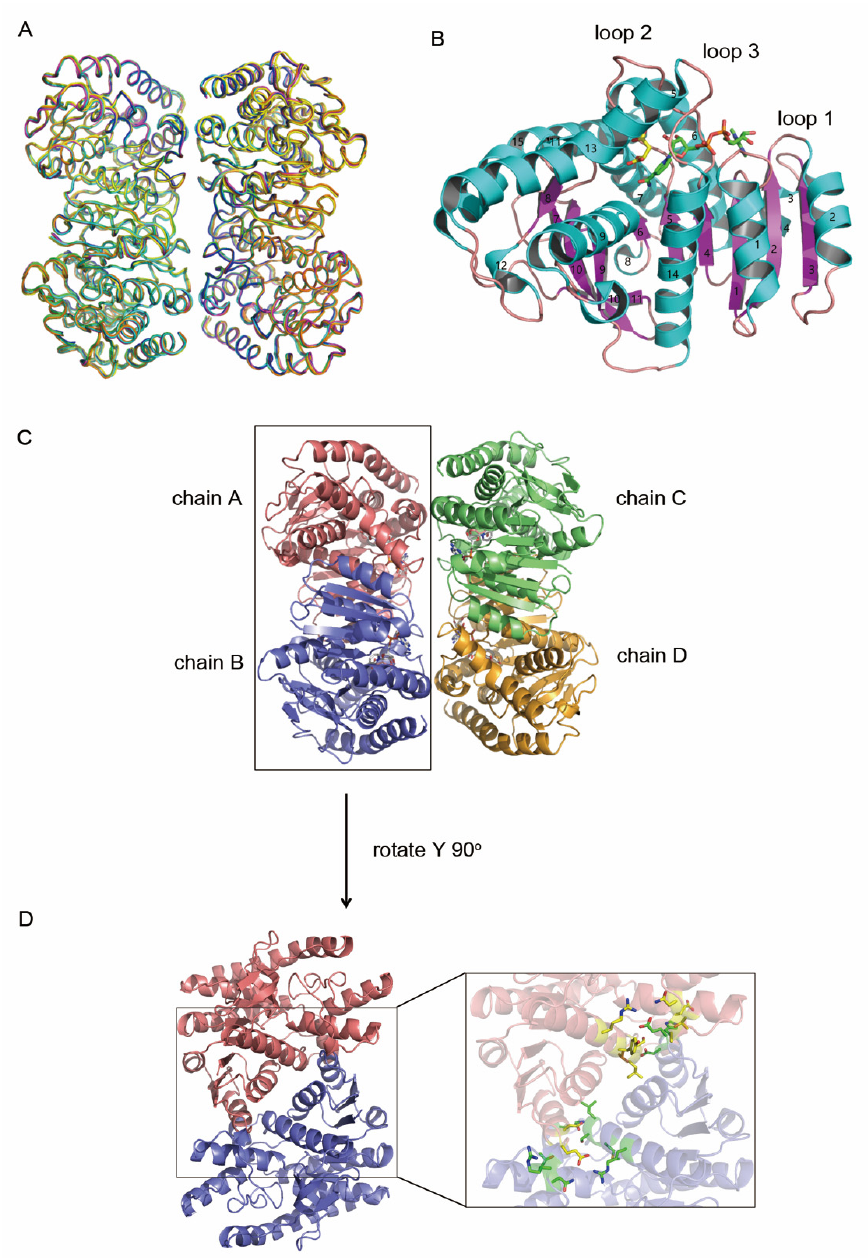
Figure 1. Overall structure of hMDH2. ( A ) Ribbon representations of the superimposed structures of hMDH2 complexed with various ligands (citrate bound—green; L -malate and NAD bound— cyan; L -malate bound—magenta; NAD bound—yellow; PO 4 − bound—blue; oxaloacetate and NAD bound—orange). ( B ) Cartoon diagram of hMDH2 monomer with L -malate and NAD. The α -helices are shown in cyan, the β -strands in magenta and the loops in pink. The L -malate and NAD are shown as sticks colored with yellow and green, respectively. The α -helices and β -strands are numbered in the order of appearance from the N-terminus, respectively. Three loops surrounding the active site are indicated. ( C ) A cartoon diagram showing the overall conformation of the hMDH2 tetramer from the L -malate and NAD complex structure. Bound L -malate and NAD molecules are shown in ball-and-stick representations. ( D ) Subunit A and B of hMDH2 are shown as a cartoon representation by 90° rotation around the Y -axis from ( C ). The dimeric interface is enlarged in a box. Residues involved in the hydrogen bond interactions in the dimeric interfaces are shown as yellow sticks for chain A and green sticks for chain B. The residues are not indicated, for the clarity of the figure (please see Table